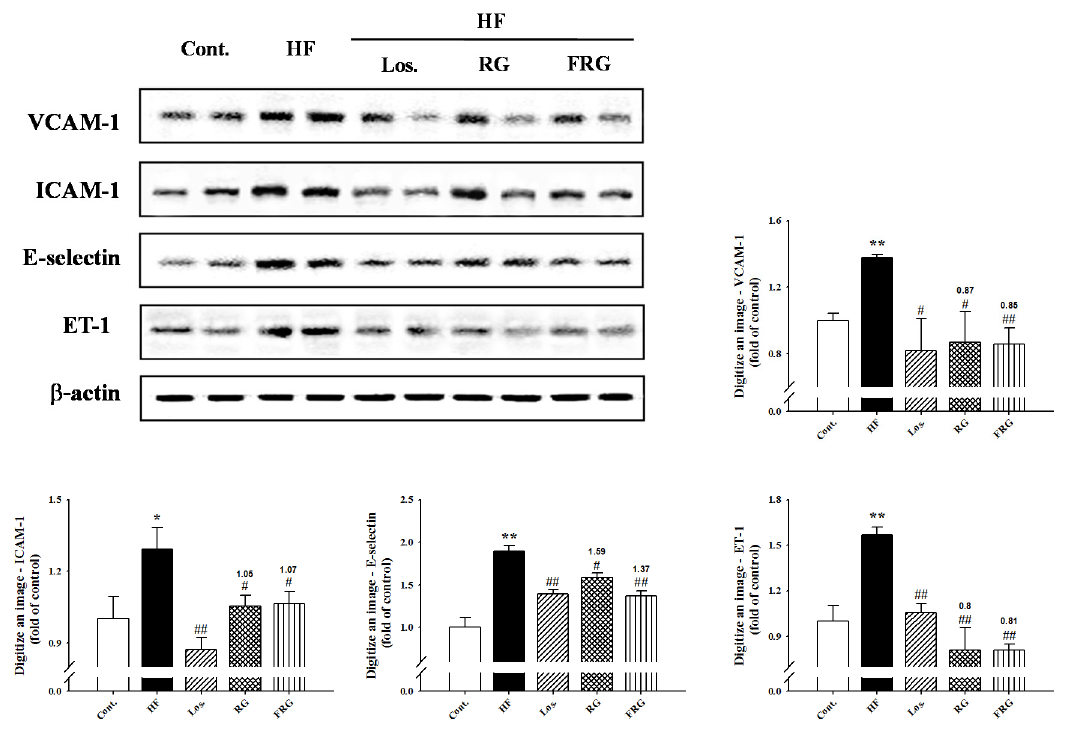
Figure 6. Effects of FRG on VCAM ‐ 1, ICAM ‐ 1, E ‐ selectinm and ET ‐ 1 immunoreactivity in aortic tissues. Representative western blots of VCAM ‐ 1, ICAM ‐ 1, E ‐ selectinm and ET ‐ 1 protein levels are quantifications are shown. Values were expressed as mean ± S.E. ( n = 3). ** p < 0.01 versus Cont.; # p < 0.05, ## p < 0.01 versus HF.